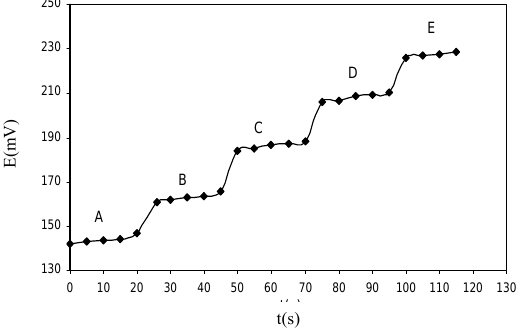
Figure 4. The dynamic response time of the holmium electrode for step changes in the Ho 3+ concentration: A) 1.0 × 10 -6 mol/L, B) 1.0 × 10 -5 mol/L, C) 1.0 × 10 -4 mol/L, D) 1.0 × 10 -3 mol/L, E) 1.0 × 10 -2 mol/L. Table 2. Comparison of selectivity coefficients, detection limit, response time and linearity range of the developed Ho 3+ sensor and the formerly mentioned Ho 3+ ion-selective